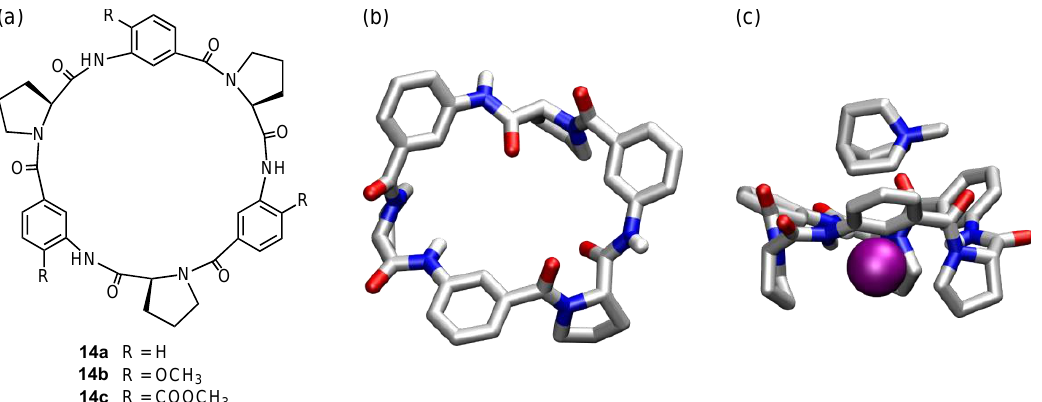
Figure 8. Structures of the cyclic peptides 14a – c ( a ), crystal structure of 14a (CSD Entry: KIQXUD) ( b ), and crystal structure of the N -methylquinuclidinium iodide complex of 14a (CSD Entry: KIQYAK) ( c ). Solvent molecules, counterions, and protons, except acidic ones, are omitted for reasons of clarity.